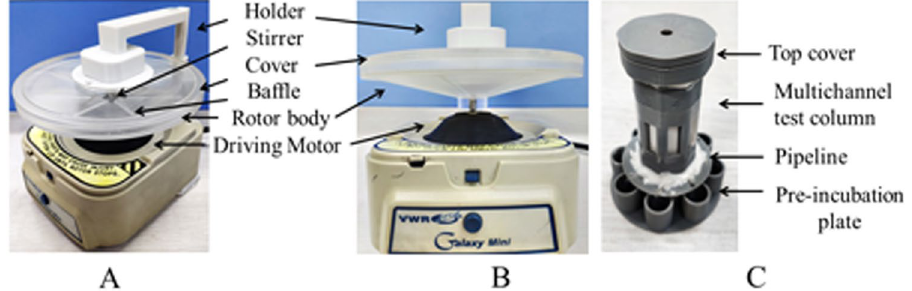
Figure 1. Mixing–centrifugation device ( A , B ). Pre-incubation sampling device ( C ).